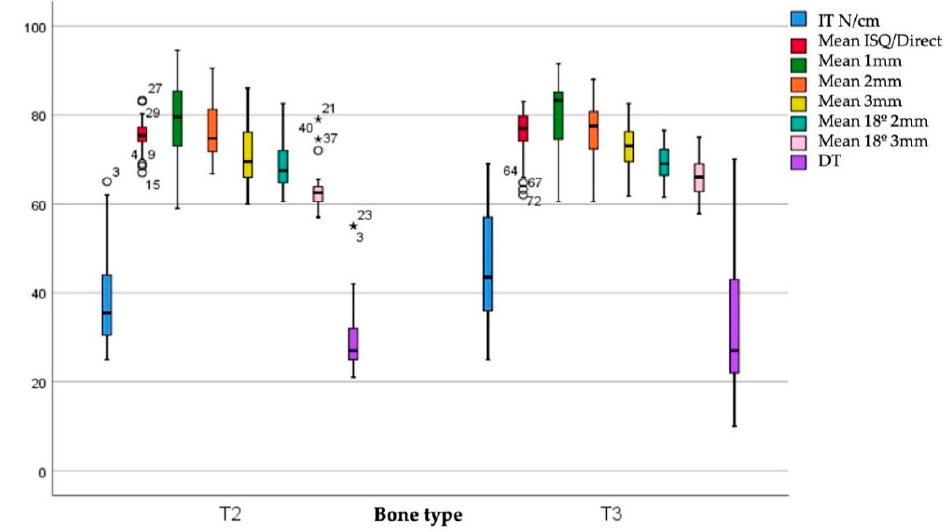
Figure 5. IT and DT. ISQ values according to bone type.